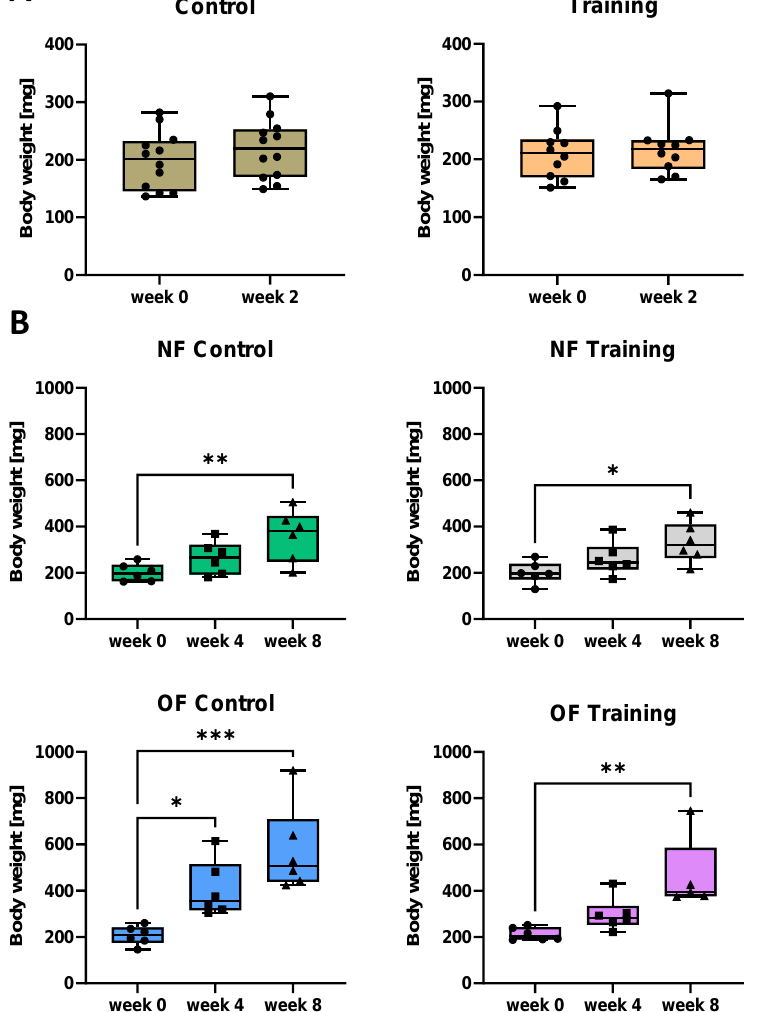
Figure 3. Swim tunnel training prevented weight gain in zebrafish only moderately. ( A ): phase 1 training did not alter zebrafish body weight. Control: N = 12 fish; Training: N = 10 fish. Two-tailed unpaired t -test. ( B ): phase 2 training hardly prevented weight gain in normalfed and overfed zebrafish, respectively. Body weight increased after 4 weeks significantly in the OF-control group ( p = 0.0461). After 8 weeks, body weight was increased in both the NF and OF-control group ( p = 0.0090 and 0.0006, respectively) and in the training groups ( p = 0.0161 and 0.0021, respectively). N = 6 fish per group. One-way ANOVA test or Kruskal-Wallis test. NF: normal feeding; OF: overfeeding. * p < 0.05, ** p < 0.01, *** p <